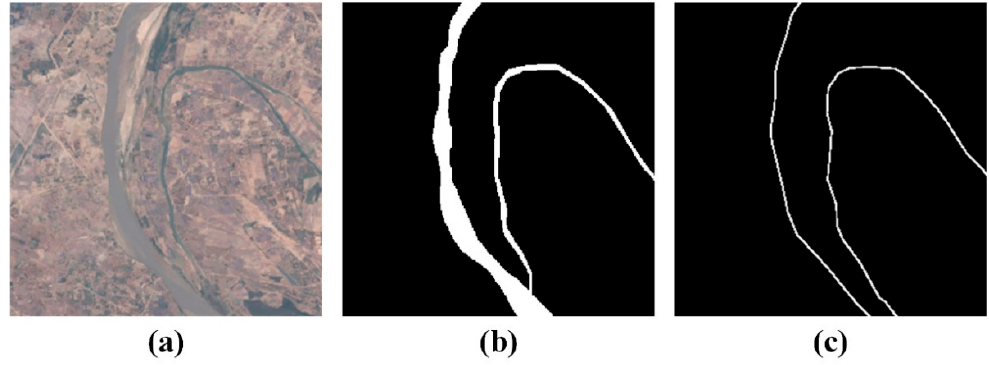
Figure 1. ( a ) Sample patch from very high-resolution Landsat 8 image patch, ( b ) the pixel-level ground-truth labels, and ( c ) OSM-based sparse scribbled annotations.